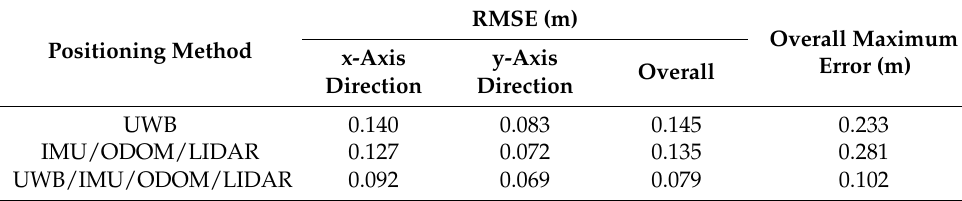
Table 5. Error analysis of target points positioning with different positioning methods.